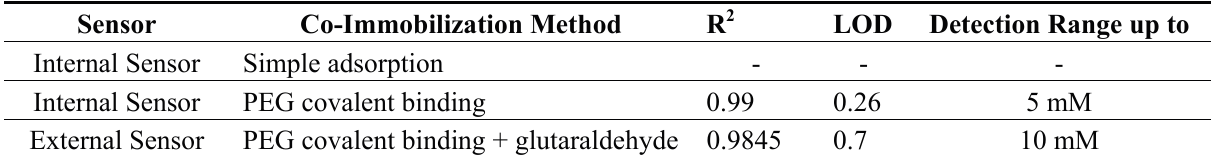
Table 1. Summary of the different sensor designs performance and co-immobilization